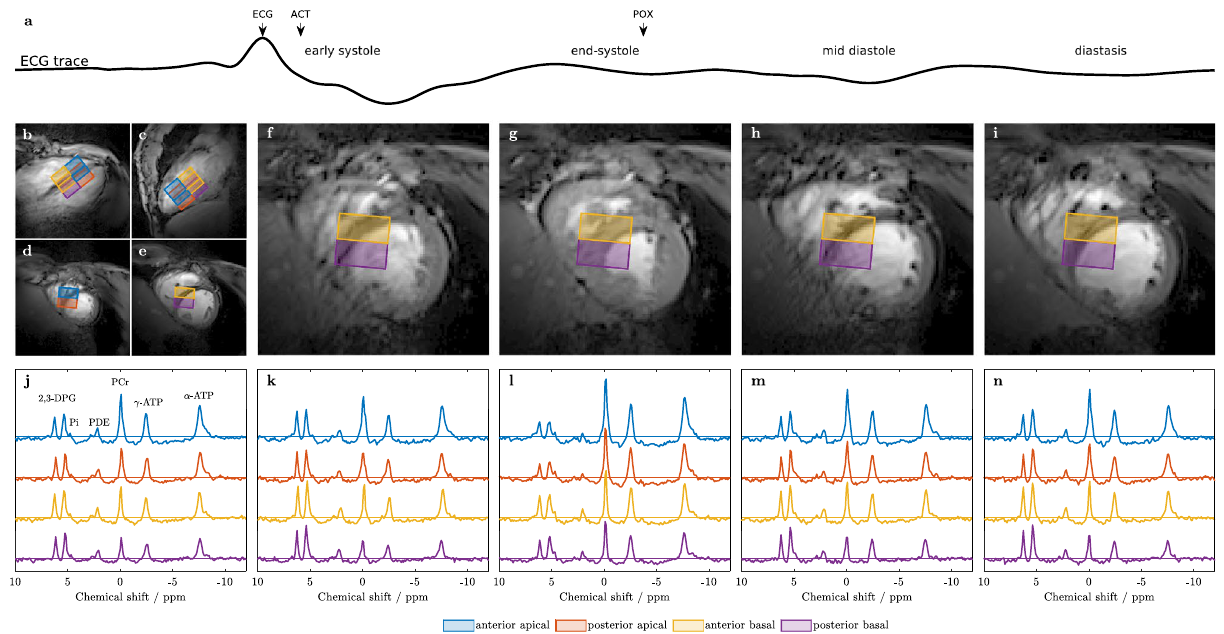
Figure 1. ( a ) Sample ECG trace of a single cardiac cycle depicting the trigger signals of ECG, acoustic sensor (ACT) and pulse oximeter (POX), and the four examined cardiac phases: early systole, end-systole, early diastole and diastasis. ( b – e ) Voxel positioning is shown on ( b ) 2-chamber, ( c ) 4-chamber, ( d ) apical short-axis and ( e ) basal short-axis cine localizer MR images. ( f – i ) Central short-axis cine images acquired at the four distinct cardiac phases according to the ECG trace (( f ) early systole, ( g ) end-systole, ( h ) early diastole, ( i ) diastasis) visualize the extent of cardiac contraction. ( j ) 31 P spectra of the untriggered and ( k – n ) the four triggered scans corresponding to the short-axis images ( f – i ) above. Voxel positions are color-encoded as depicted in the legend. Metabolite resonances of PCr, α - and γ -ATP, 2,3-DPG and PDE are well resolved in all spectra and even the P i resonance can be detected in most of the individual single-voxel